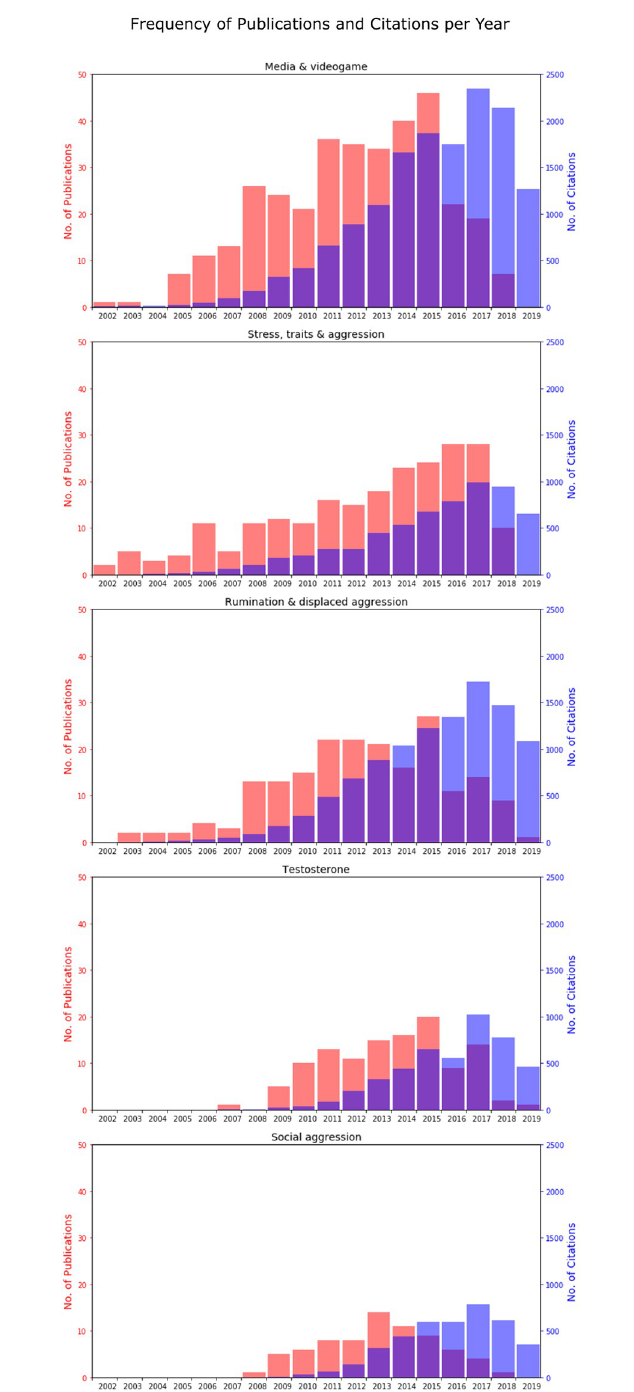
Fig 4. Community growth. The bar charts represent the frequency of publications (in red) and number of citations (in blue) per year by community (for the 5 largest communities). On the x-axis are represented the years between 2002 (year of origin of the network: the seed paper was published in 2002) and 2019 (end of data gathering). It is possible to notice that in every community there is a steep decrease of publications and citations in the year 2019. We suspect that this trend might be due to a delay in the uploading of papers in the semantic scholar database and it should not have to reflect a real significant decrease of the interest in the field.